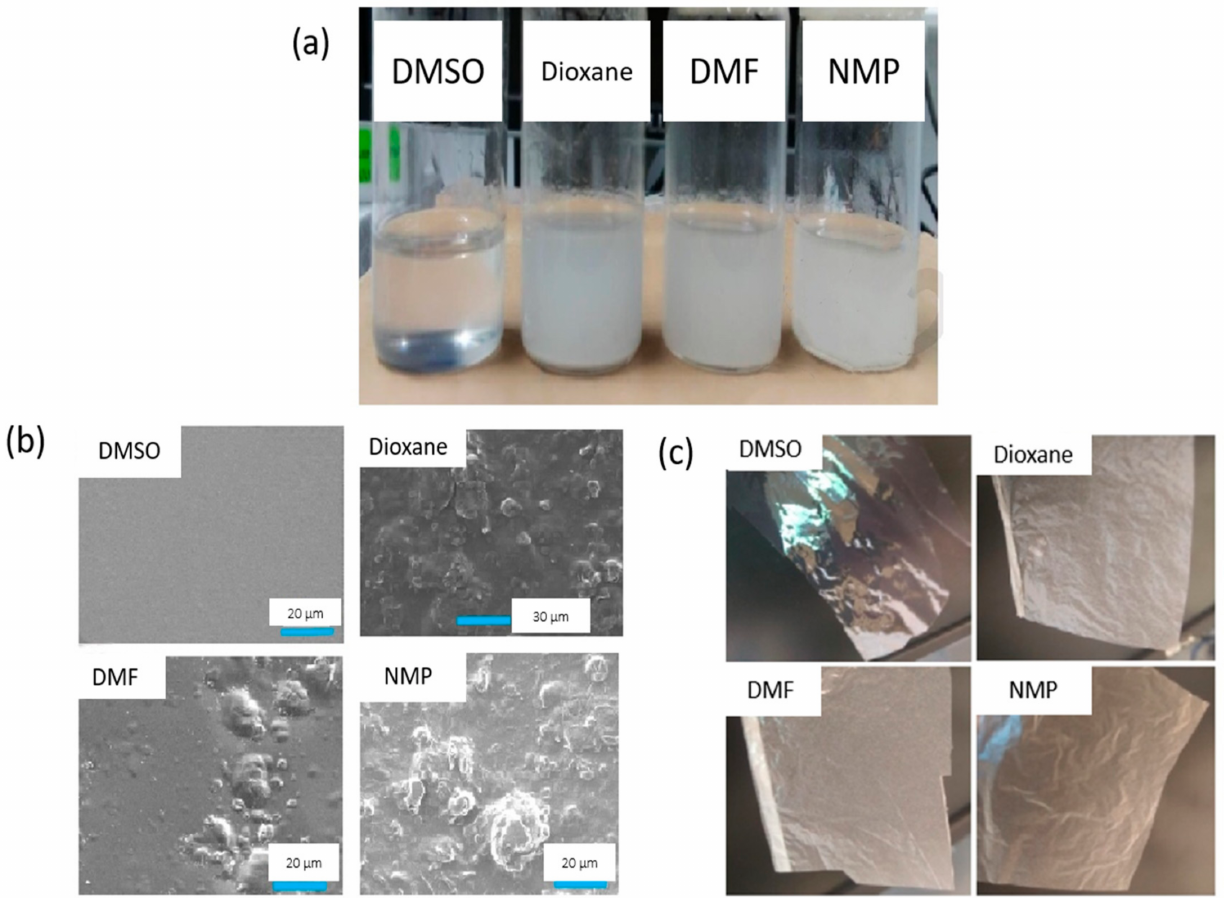
Figure 4. Labelled diagrams of: ( a ) Cellulose nanocrystals (CNCs) suspension in different solvents; ( b ) SEM images of nanocomposite membranes formed from different solvents; and ( c ) photographs of nanocomposite membranes formed from different solvents